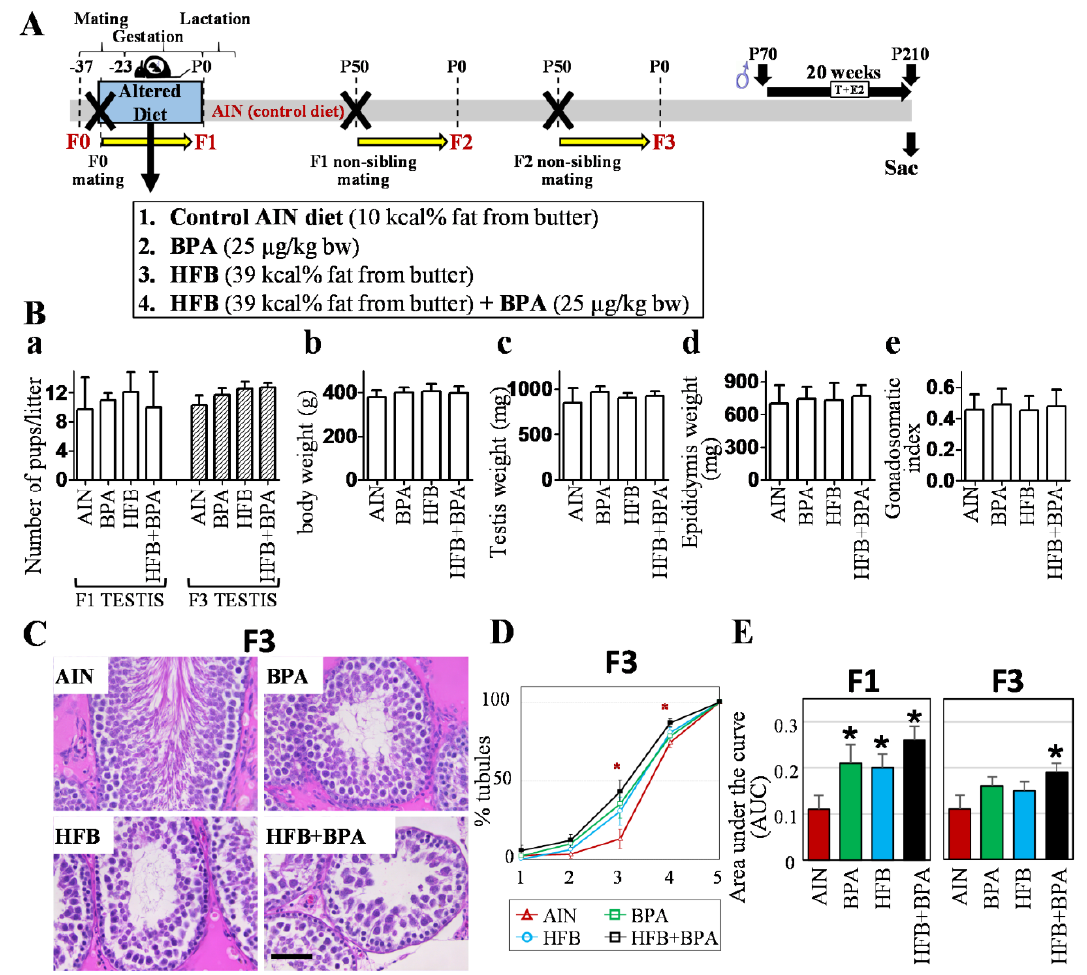
Figure 1. Impaired spermatogenesis in testes of T + E2 − implanted F3-generation male offspring. ( A ) Scheme of dietary exposure groups, mating and T + E2 treatments. F0 dams were fed indicated diets during mating and gestation. Diets were changed to AIN diet after pups were born. Pups and their descendants were fed AIN diet. On PND 50, gestationally exposed F1 males and females from different litters were mated within each group, resulting in F2 offspring. Again, on PND 50, F2 offspring were similarly mated, resulting in F3 offspring. F3 males underwent T + E2 implantation. ( B ) Litter size and weight of male offspring (T + E2 model): ( a ) litter size for F1 and F3 offspring, body weight (bw) and weight of reproductive organs of male offspring for T + E2 − exposed offspring (PND 210), ( b ) body weight, ( c ) right testis, ( d ) right epididymis, and ( e ) gonadosomatic index (weight of both testis/bw × 100). Error bars indicate standard deviation. No significance was found using one-way ANOVA. ( C ) Representative tubules illustrating predominant phenotype observed for each diet group. T + E2 − implanted F3 offspring from control AIN diet group show all stages of spermatogenesis culminating in spermatozoa. BPA, HFB, and HFB + BPA group offspring show impaired spermatogenesis, with last step predominantly consisting of round and/or condensing spermatids. Bar = 60 µm. ( D ) Plot of tubules showing cumulative progression of spermatogenesis. STs were scored for spermatogenesis, showing (1) spermatogonia/atrophic tubules, (2) spermatocytes, (3) round step 8 spermatids, (4) condensed step 16 spermatids, and (5) spermatozoa as last differentiated germ cell present within STs. Curves represent progression of spermatogenesis per subject. (* p < 0.05 vs AIN group). ( E ) Comparison of area under the curve (AUC) as a measure of spermatogenesis among groups. (* p < 0.05). Two sections examined per animal .